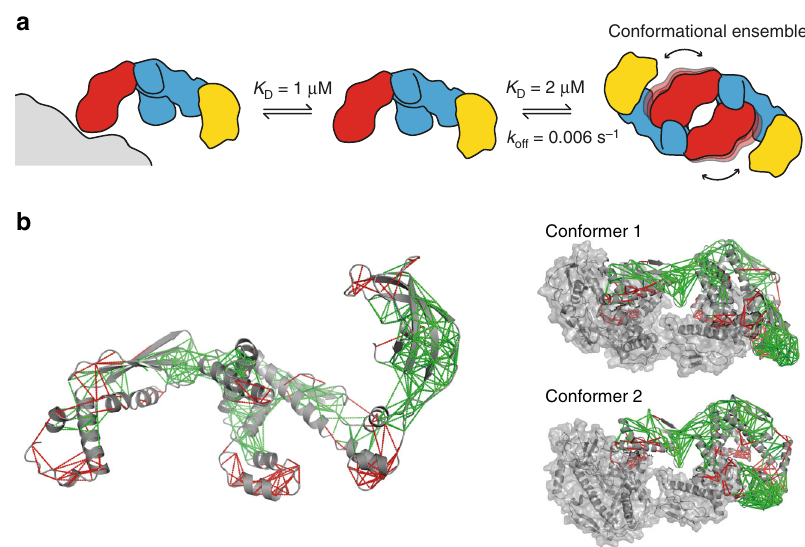
Fig. 6 Equilibrium and frustration of the TF dimer in solution. a TF dimer is highly dynamic and is in equilibrium in solution with its monomeric form and with its ribosome-bound form. The ribosome is represented in gray. b Frustration analysis of TF. Local frustration for TF crystal structure was calculated with the online tool Protein Frustratometer 2 34 (PDB 1W26) and is plotted on TF crystal structure (left) and on the dimer structural models (right). Minimally frustrated interactions are depicted as green lines, highly frustrated interactions as red